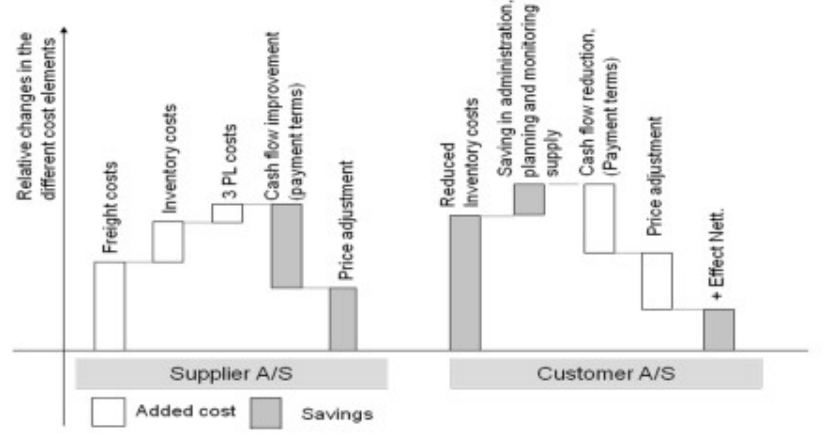
Figure 3. Effects of the VMI project on financial goals (source: provided by the case